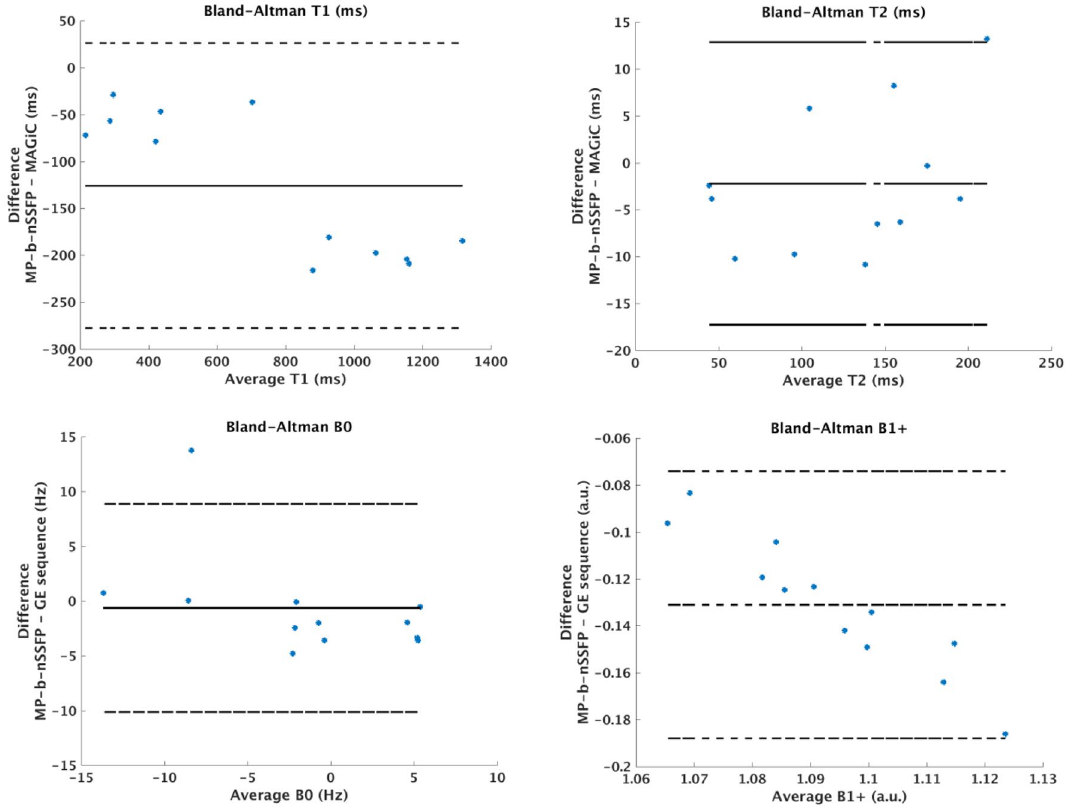
Figure 7. Bland–Altman plots comparing ROI mean T 1 and T 2 values of the proposed MP-b-nSSFP sequence with the “ α x − γ y − α y − γ x ” scheme ( α = 90 ; γ = 175 ) and